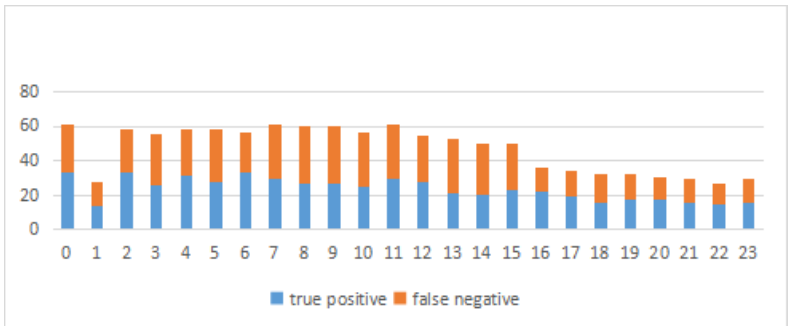
Figure 9. True positives and false negatives in all the testing frames.